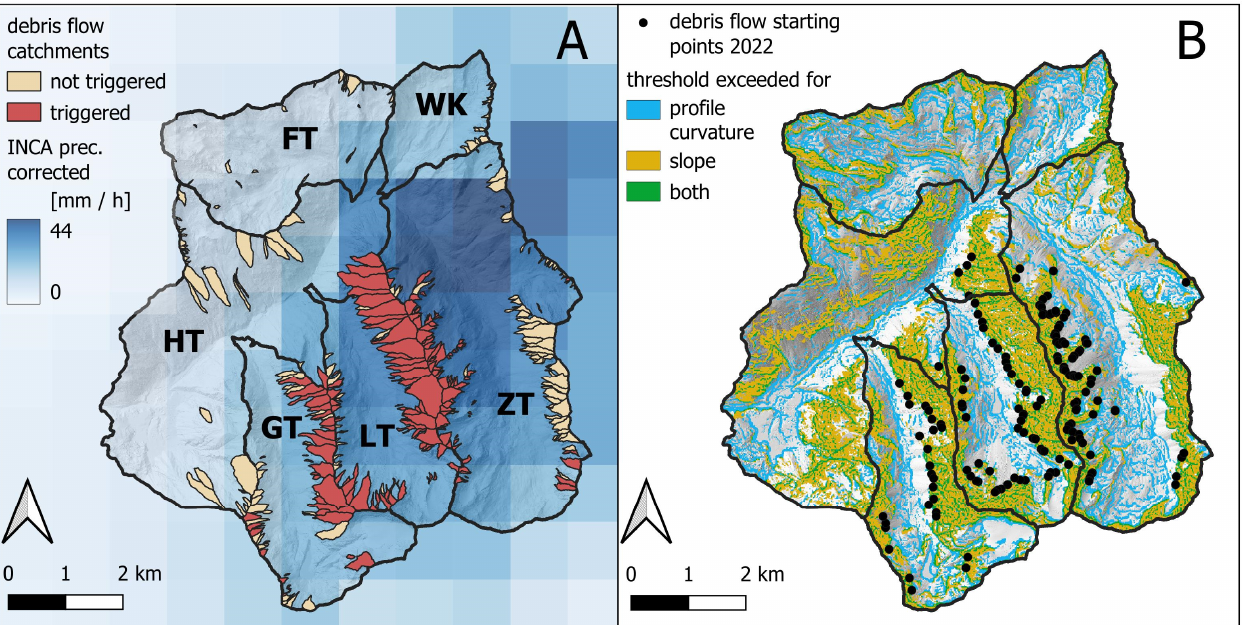
Figure 13. A: The mapped debris flow catchments in Horlachtal, which have been active at least once since 1947. Catchments that did not trigger a debris flow in July 2022 (brown) can be distinguished from catchments that did (red). For discussing the spatial distribution of the initiated debris flows, the INCA rainfall data (with corrected absolute values) of the event on 20 July is depicted as well. B : Areas for which the relief parameters slope and profile curvature exceeded a threshold value. These thresholds were set to the values of the 75 th percentile of the starting points of the 156 debris flows in July 2022 for the respective parameter.